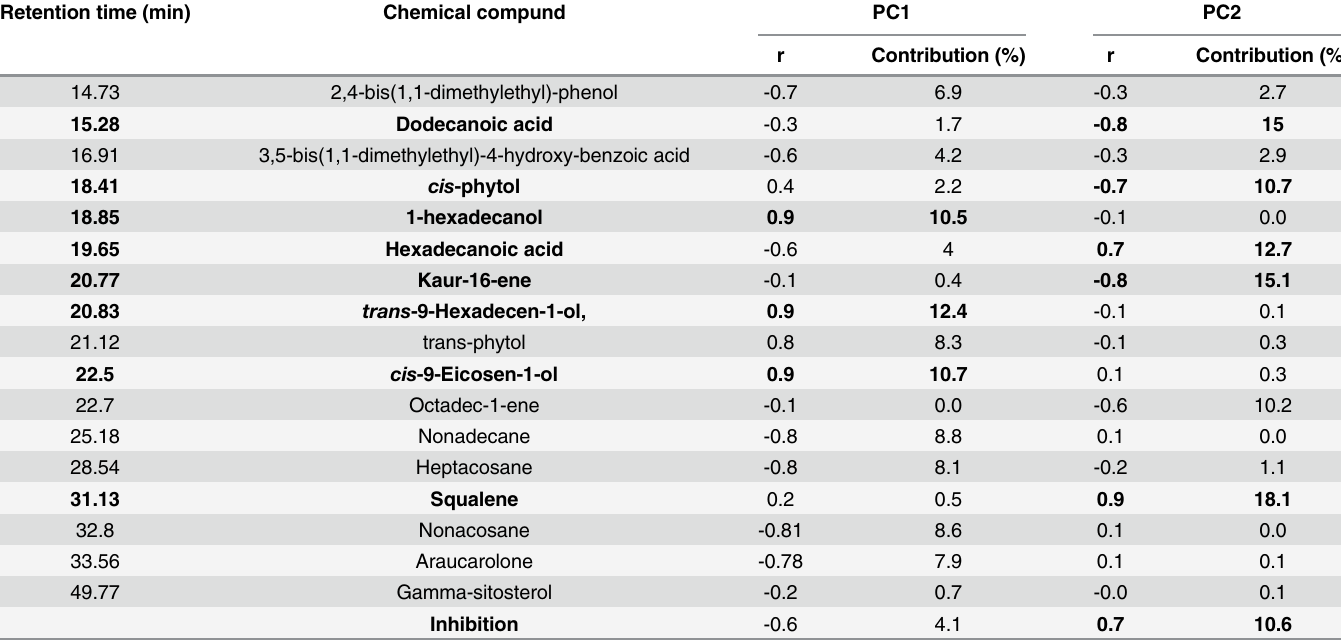
Table 4. Retention time, coefficient of correlation and percentage of contribution of each variable to the total length of the PC1 and PC2. The ana- lyzed variables were the inhibition of seed germination of T . recurvata and 17 chemical compounds identified with GC-MS in the bark of Ipomoea murucoides . In bold those chemical compounds whose percentage with contribution (cid:4) 10% to the eigenvalue